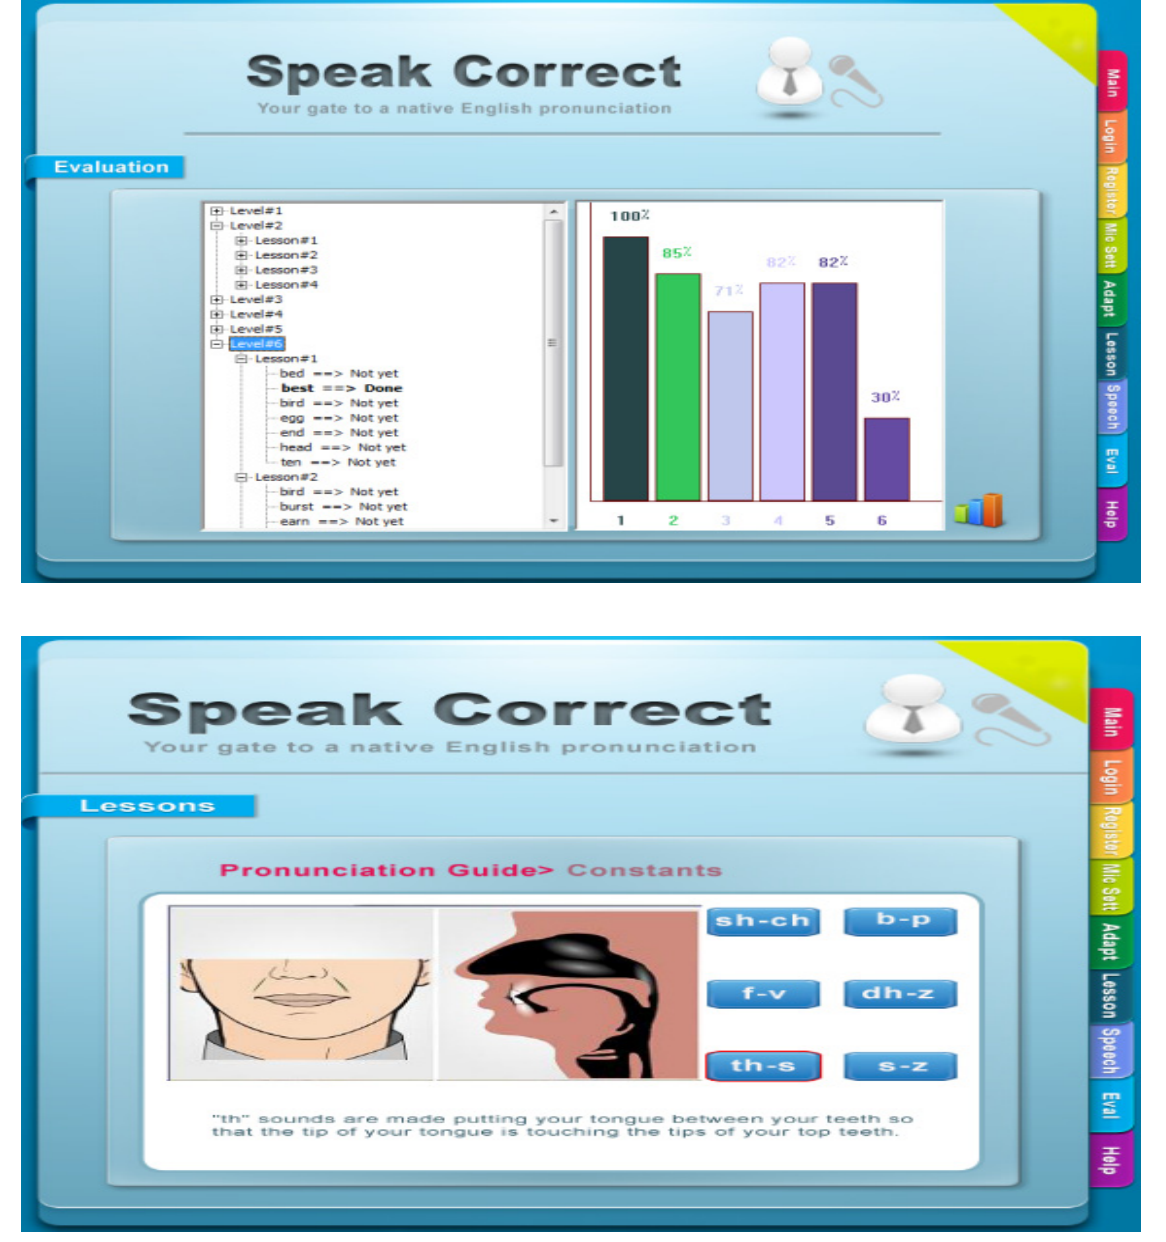
Figure 5. The levels and associated lessons testing the Speak Correct system.